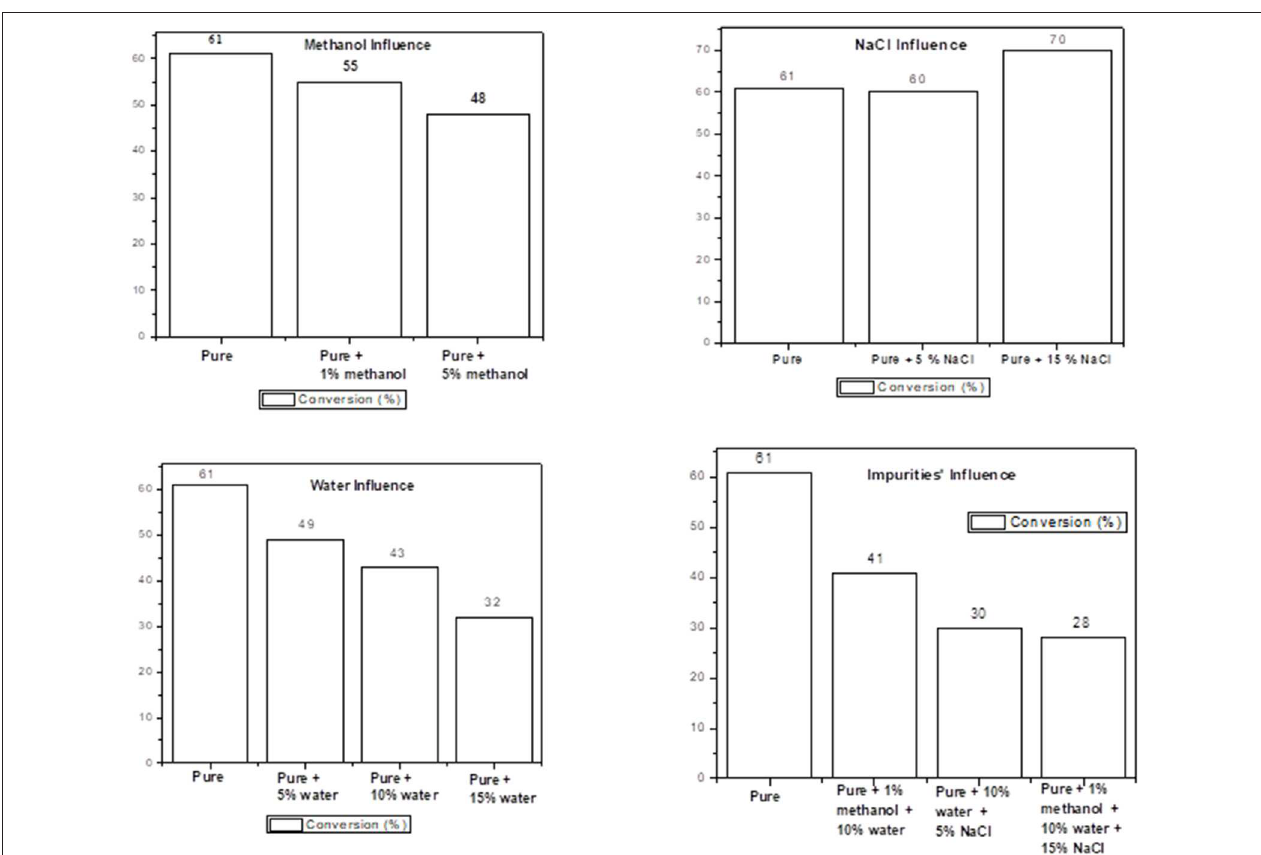
FIGURE 2 | Results of the tests with doped glycerin.